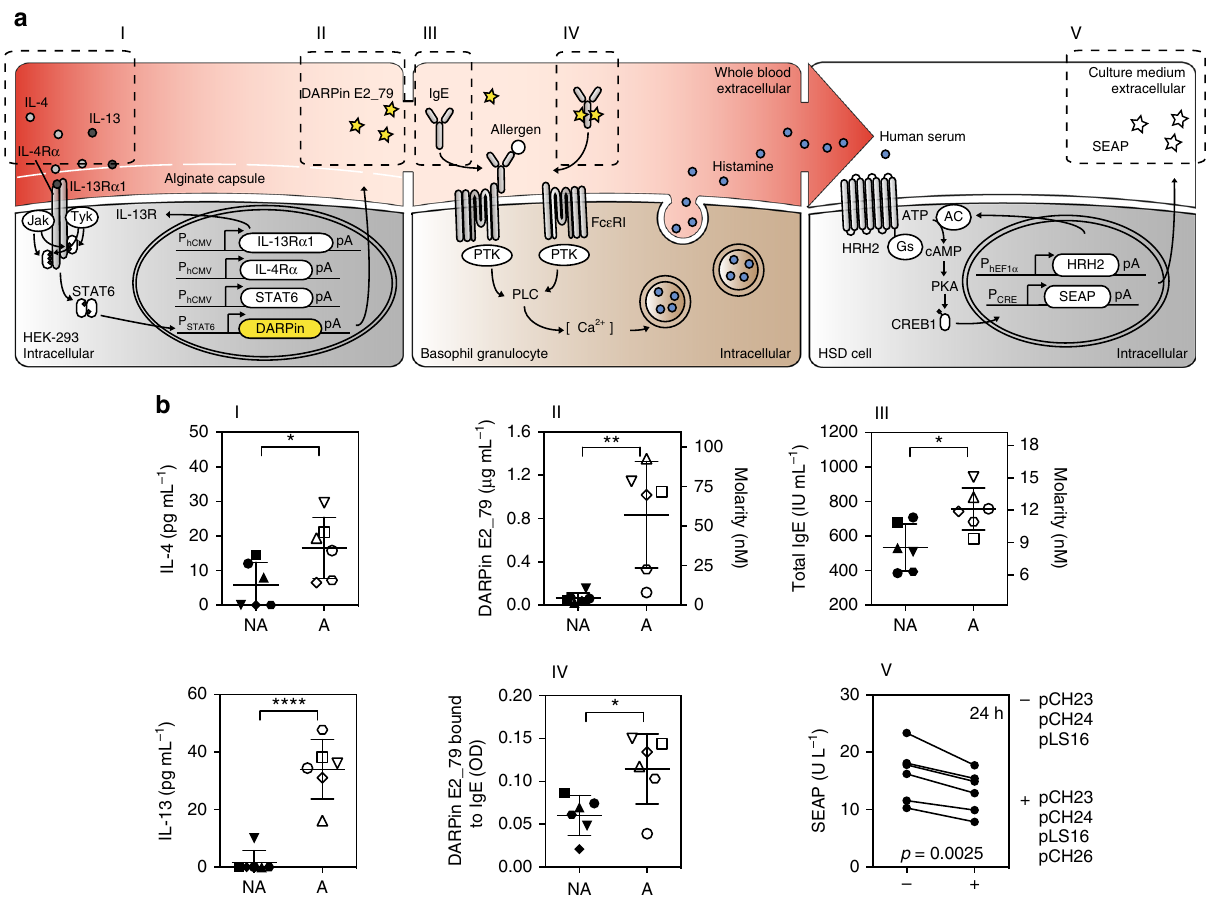
Fig. 4 DCS-controlled DARPin E2_79 production in the human blood. a Illustration of the operational analysis procedure of the DCS-controlled DARPin E2_79 performance in human whole blood. 8 × 10 5 microencapsulated HEK-293 cells transgenic for DCS-controlled DARPin E2_79 (200 cells per capsule, 4000 capsules) were cultivated in 0.5 mL of human blood diluted 1:1 in RPMI-1640 for 24 h during which the allergen-associated cytokines IL-4 and IL-13 in the donor ’ s blood (I) trigger DCS-controlled production and secretion of DARPin E2_79 (II). IgE in the blood of the different donors (III) is bound by the produced DARPin E2_79 (IV). Addition of allergen extracts results in speci fi c release of histamine by the basophil granulocytes in the donor ’ s blood. Histamine levels and thus overall DCS performance is quanti fi ed by histamine-sensitive SEAP production (V) using a HSD-transgenic reporter cell line (HSD cells). b Quantitative analysis of the DCS performance parameters including (I) IL-4 and IL-13 concentrations (24 h), (II) DARPin E2_79 production levels (24 h), (III) total IgE levels (24 h) and (IV) DARPin E2_79-bound IgE in the blood of non-allergic (NA) and allergic (A) donors (24 h). Symbols are assigned to each donor throughout graphs I, II, III, and IV. (V) Allergen-triggered DCS-controlled DARPin E2_79 impact on histamine release a , b . Allergen extract was added to the whole-blood sample of six allergic donors that contained the microencapsulated HEK-293 cells transgenic for DCS-controlled DARPin E2_79 production ( a , b , V). Control cells lacking DCS ’ s DARPin E2_79 reporter gene pCH26 (P STAT6/cEBP - SS SEAP -His-DARPin E2_79 -pA) were run in parallel. Whereas histamine levels remain high in the control group, the histamine release of the blood basophil granulocytes is reduced signi fi cantly to basal levels after 24 h. Data represent means ± s.d. of two histamine release assays. I, II, III, IV: Data are means ± s.d. of each blood donor sample ( n = 6) measured in duplicate. * p < 0.05, ** p < 0.005, **** p < 0.00001, two-tailed Student ’ s t -test. V: Data are means ± s.d. of each blood donor sample ( n =